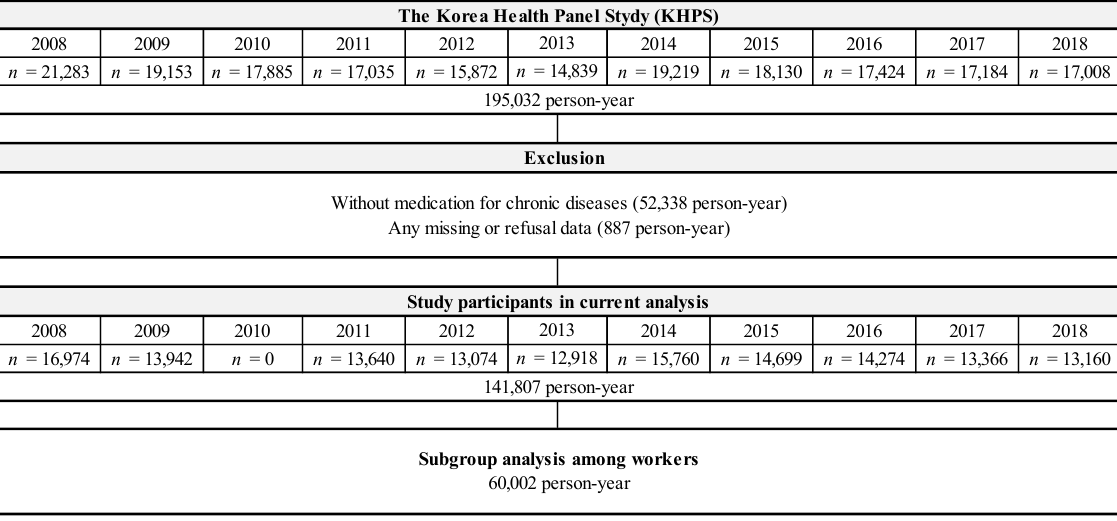
Figure 1. Schematic diagram depicting the study population.